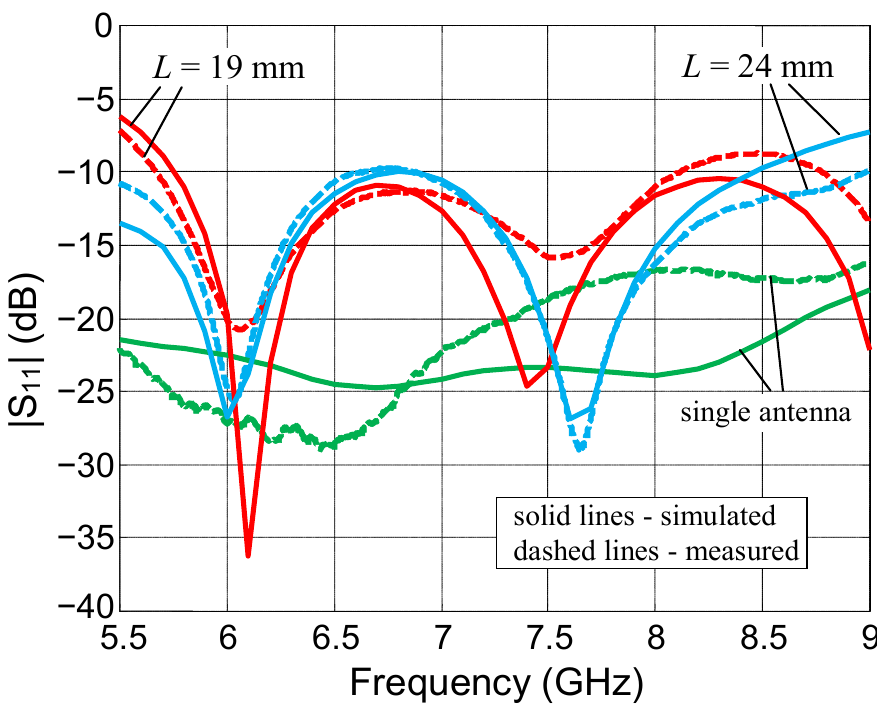
Figure 4. Simulated and measured | S 11 | of proposed antennas.